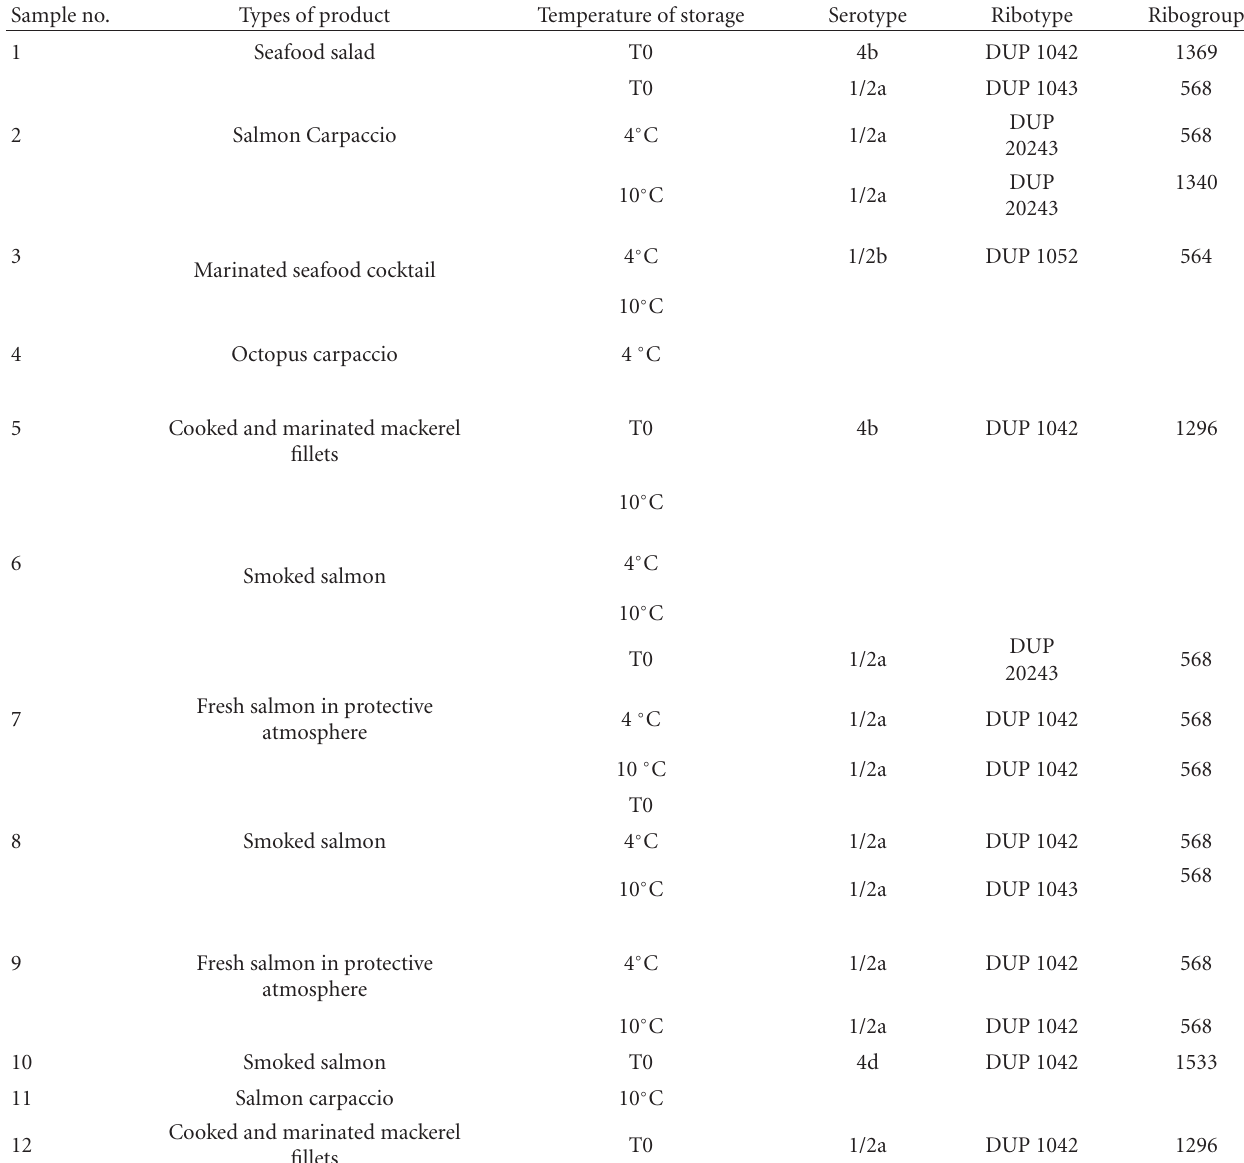
Table 4: Serotyping and ribotyping results on isolated L. monocytogenes strains. Sample